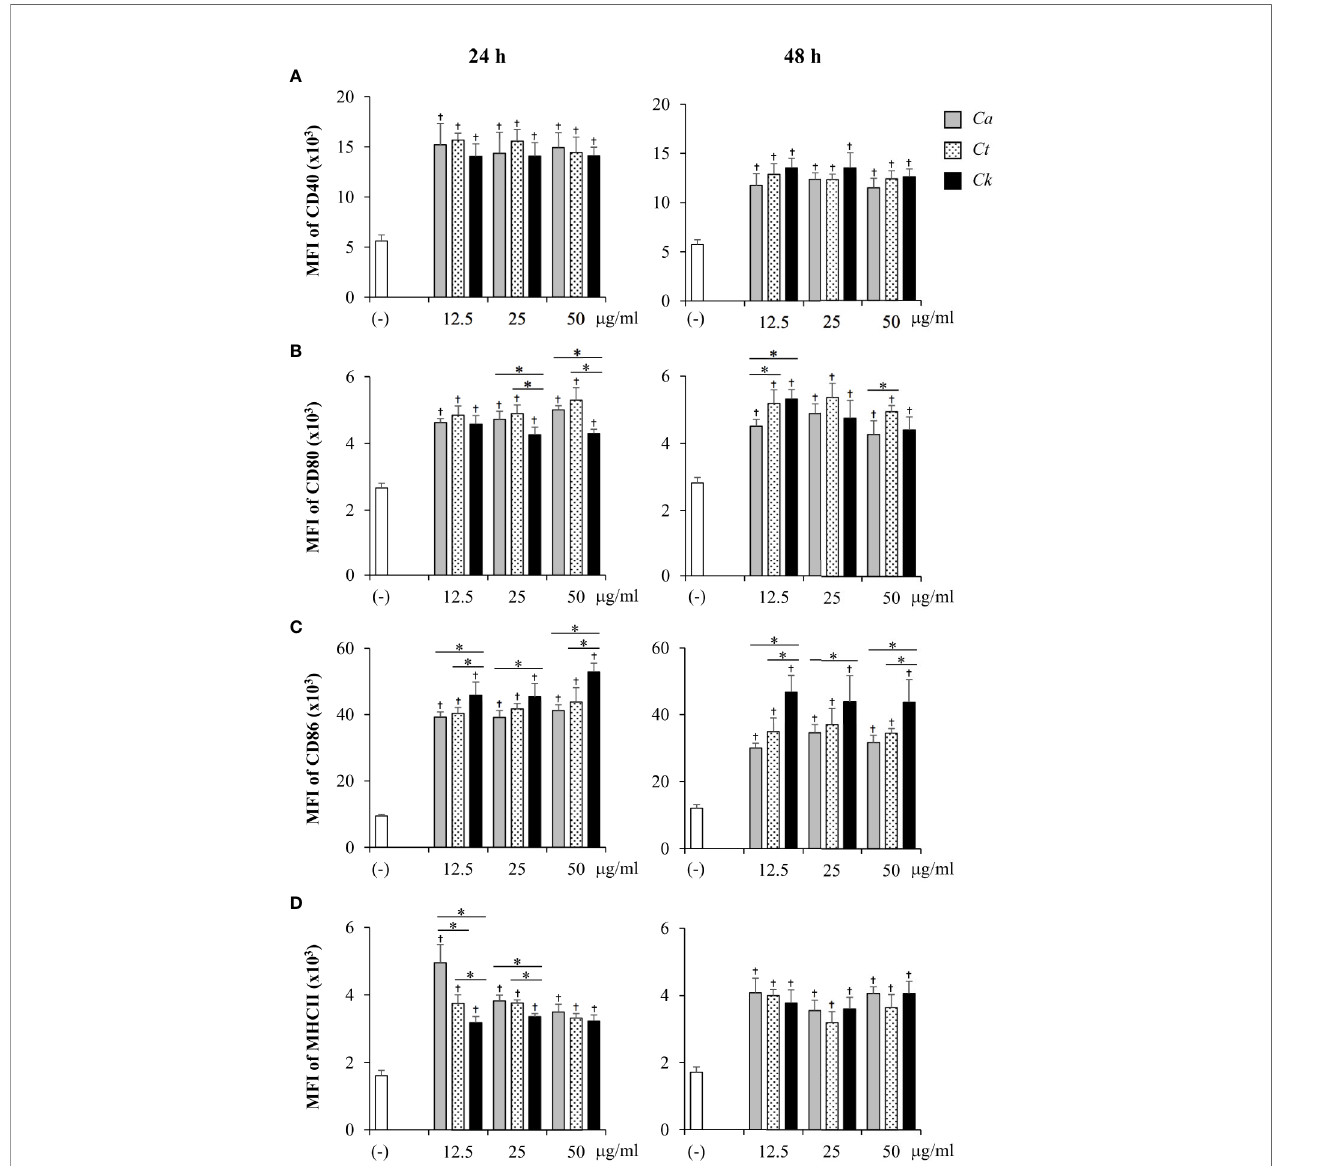
FIGURE 4 | Differential DC maturation following stimulation with distinct Candida b -glucans. Bone-marrow derived dendritic cells (BMDCs) were stimulated with 12.5, 25, and 50 µg/ml of b -glucans isolated from C. albicans , C. tropicalis , and C. krusei for 24 h and 48 h, and the geometric mean fl uorescence intensity (MFI) of dendritic cell (DC) maturation markers (A) CD40, (B) CD80, (C) CD86, and (D) MHC class II on CD11c + cells were determined using histogram analyses. n = 5; data are representative of two independent experiments. † p < 0.05 compared with unstimulated BMDCs, * p < 0.05. (-), unstimulated BMDCs; Ca , C. albicans ; Ct , C. tropicalis ; Ck , C. krusei